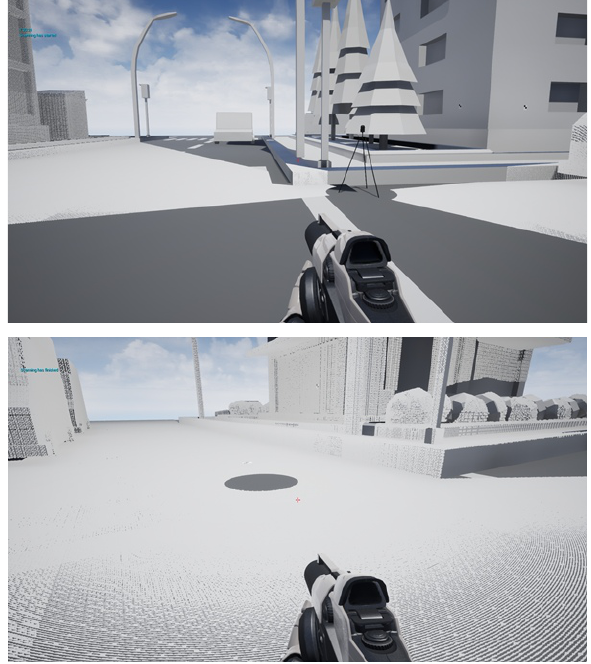
Figure 4: Different scanning periods: top – scanning start, down – end of scanning. The user’s gaze and navigation control is simulated by an available device, a gun, but will be replaced by another tool in further development.